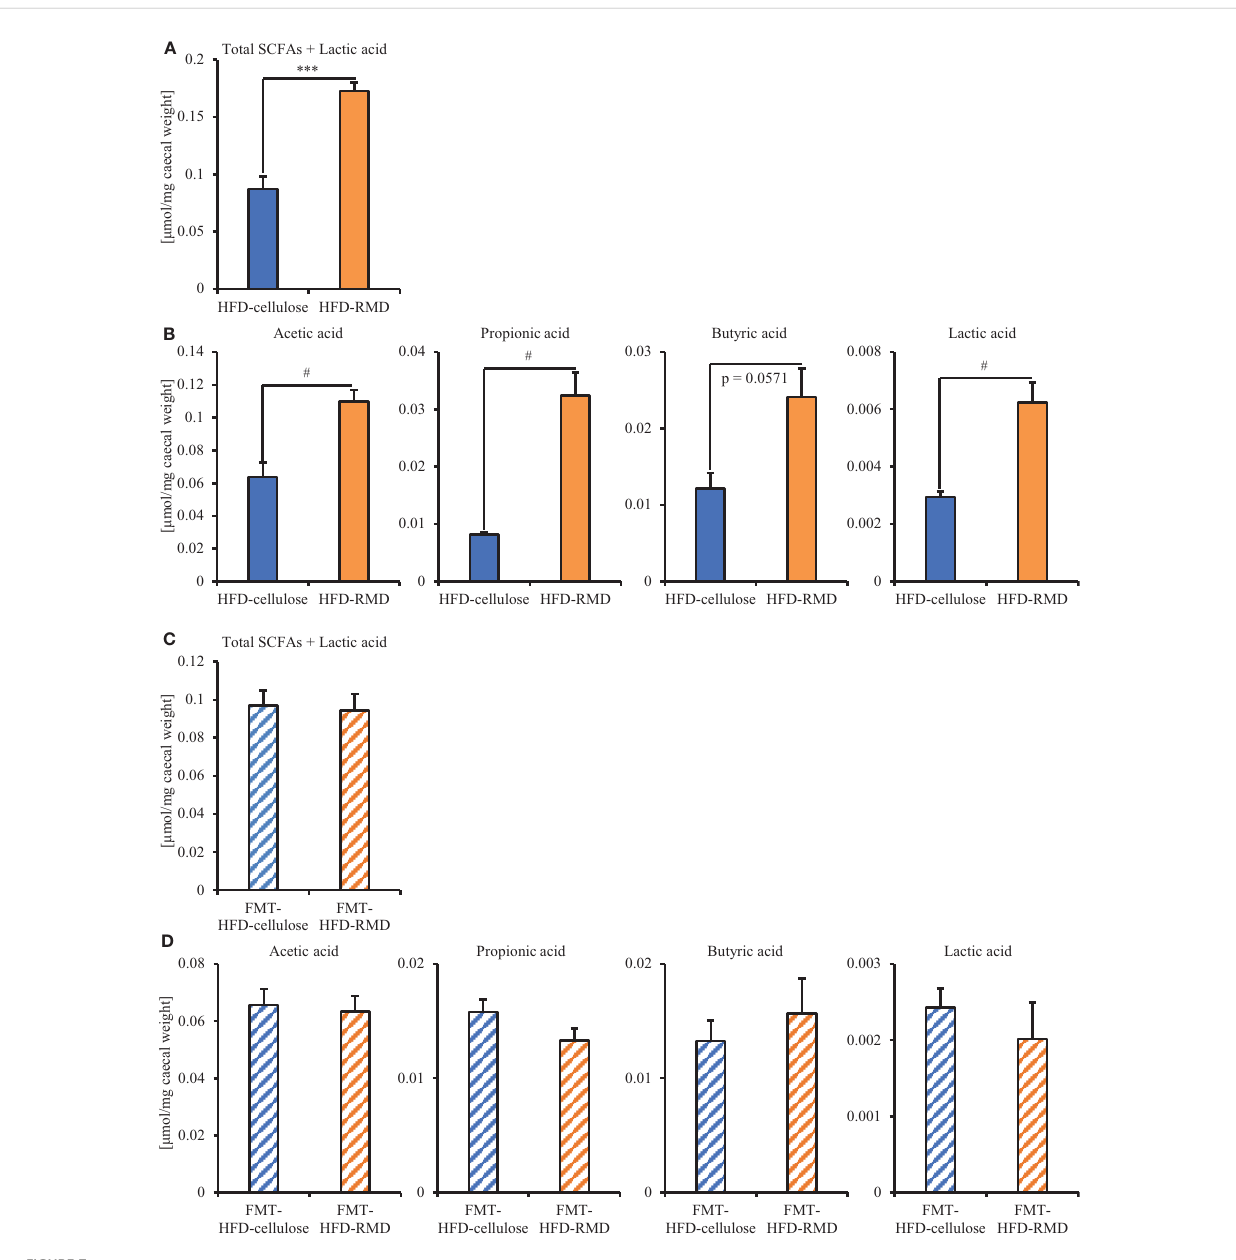
FIGURE 7 Quantitation of SCFAs and lactic acid in FMT donor and recipient mice. Total SCFAs, each SCFAs components, and lactic acid quanti fi ed in cecal contents from (A, B) FMT-donor and (C, D) FMT-recipient mice. Data are shown as means ± SEM (donors, n = 4; recipients, n = 7). *** p < 0.001 (unpaired t-test). # p < 0.05 (Mann Whitney